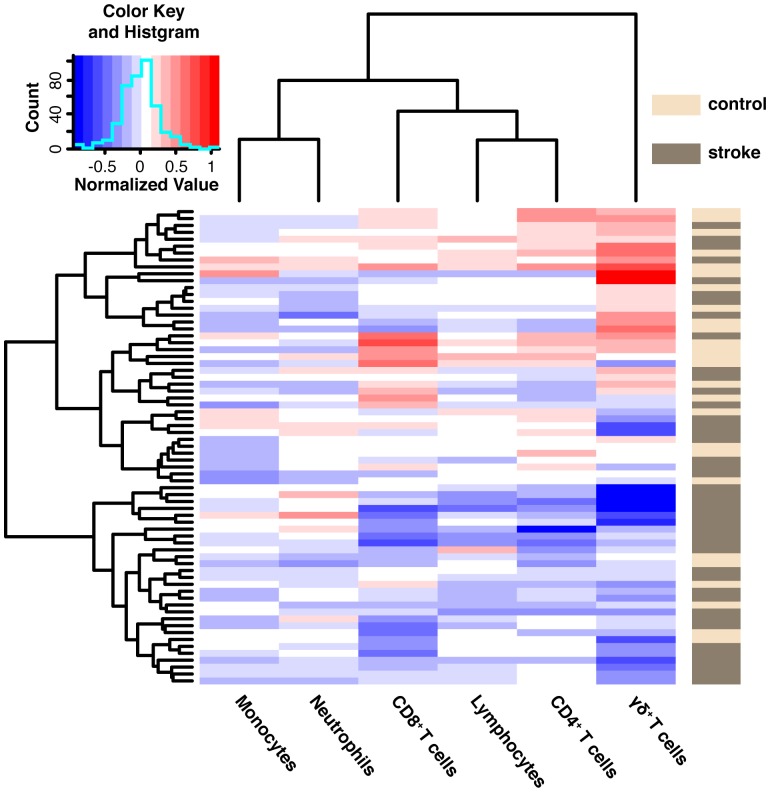
γδT cells were differentially altered in this clinical cohort relative to 5 other leukocyte subsets.This heatmap illustrates the normalized cell counts for 6 leukocyte cell subsets (columns) in the study subjects (rows). Cell numbers for neutrophils, monocytes and total lymphocytes were determined from the complete blood count, and cell numbers for CD4+, CD8+ and γδ+ T lymphocytes were measured using flow cytometry. The column dendrogram reveals clustering by leukocyte subset, demonstrating that the γδT cell subset formed a separate and dominant cluster from the other five leukocyte subsets. The γδT cell cluster separates into decreased and increased cellular counts, with decreased cellular counts predominating in the stroke subjects. This hierarchical cluster analysis used Ward's method and log-transformed and normalized cell count data.